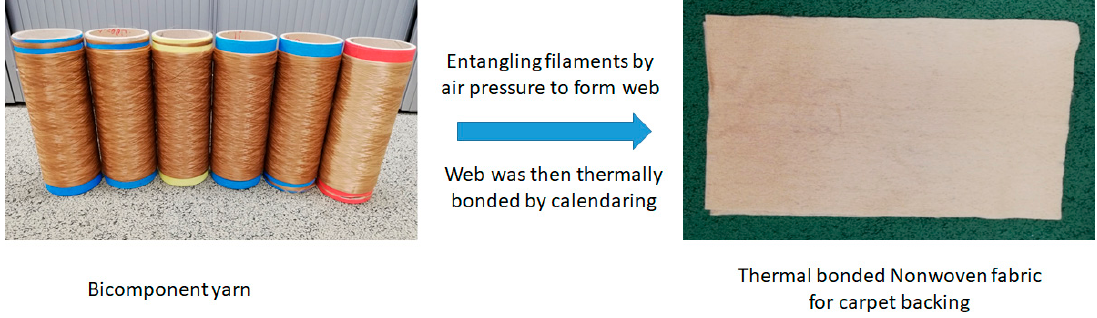
Figure 2. Bicomponent filaments and thermal bonded nonwoven fabric.